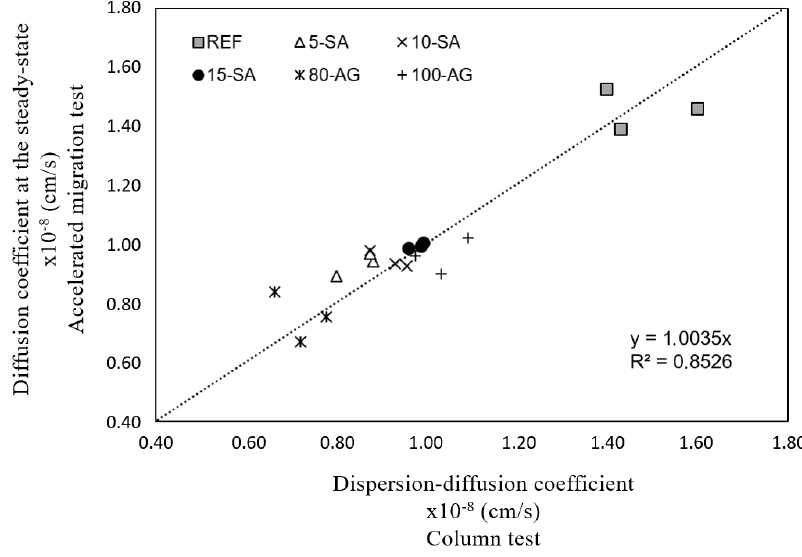
Figure 12. Correlation between ion migration tests and column